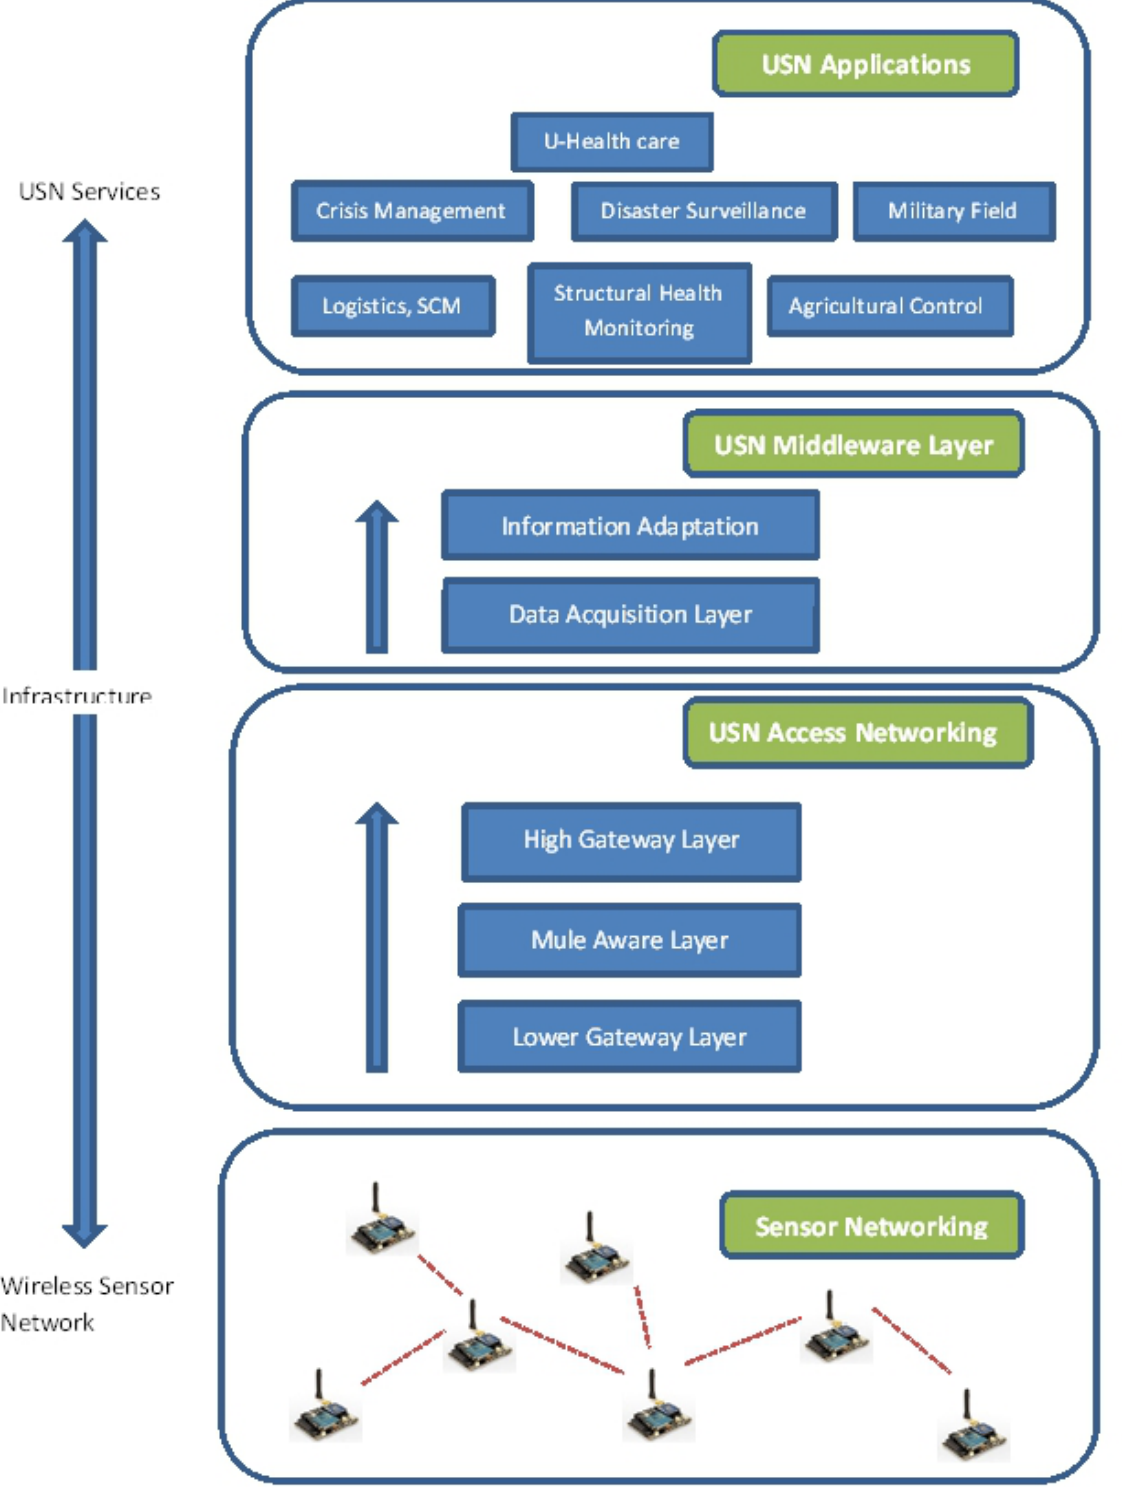
Figure 1. The USN4D Architecture. ( a ) The proposed USN4D architecture; ( b ) The ITU-T USN